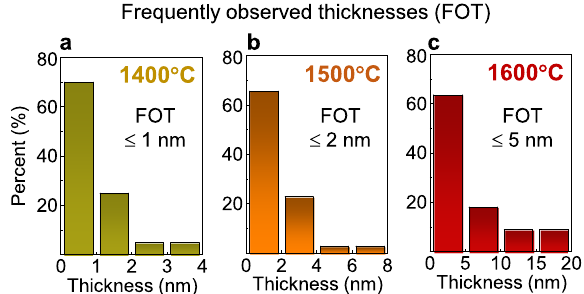
Fig. 5 | Thickness distributions of premelted amorphous layers. a − c These bar graphs present the thickness distribution of amorphous layers in samples post- annealed at 1400 ( a ), 1500 ( b ), and 1600°C ( c ). The amorphous layers become thicker, as the annealing temperature increases from 1400 to 1600°C. Frequently observed thicknesses of amorphous layers in each graph are represented as the thicknesses observed at more than 60% of grain